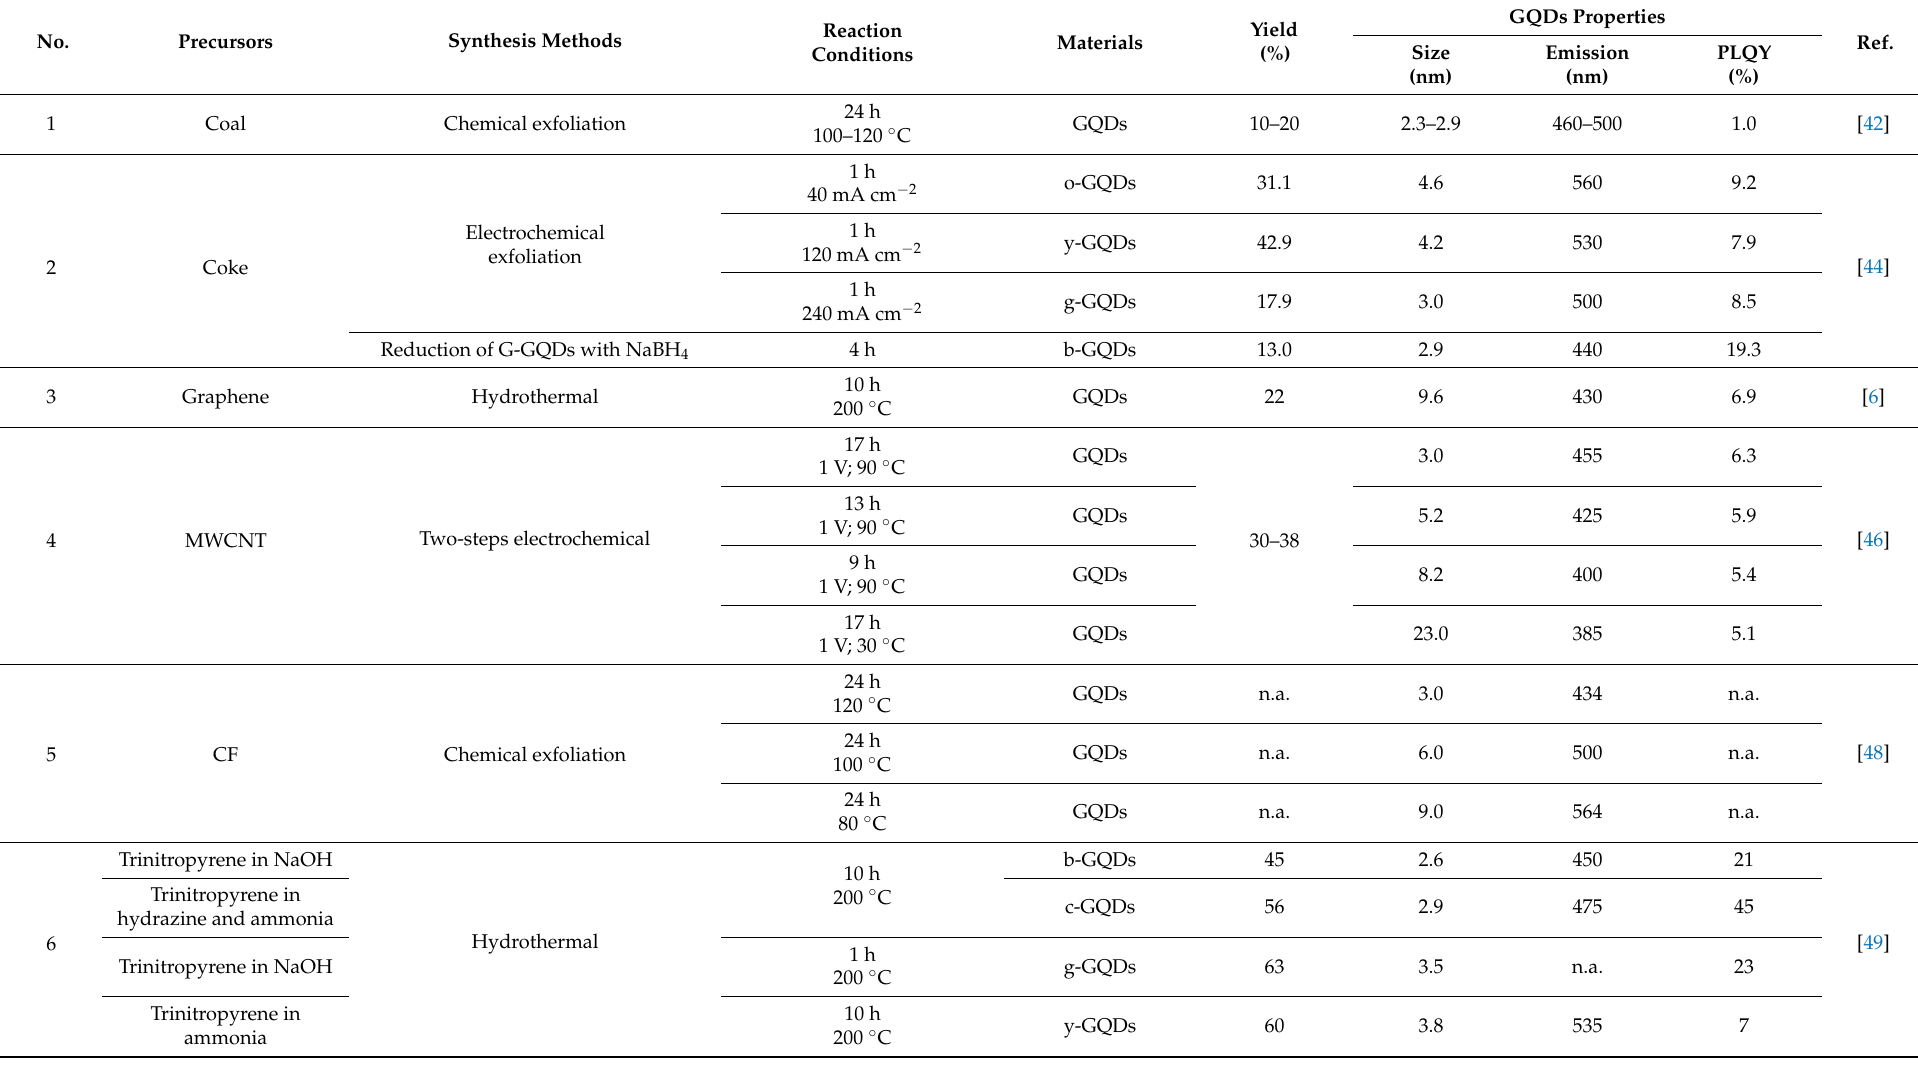
Table 1. Summary of different synthesis methods of GQDs from various precursors and the corresponding resulting GQDs’